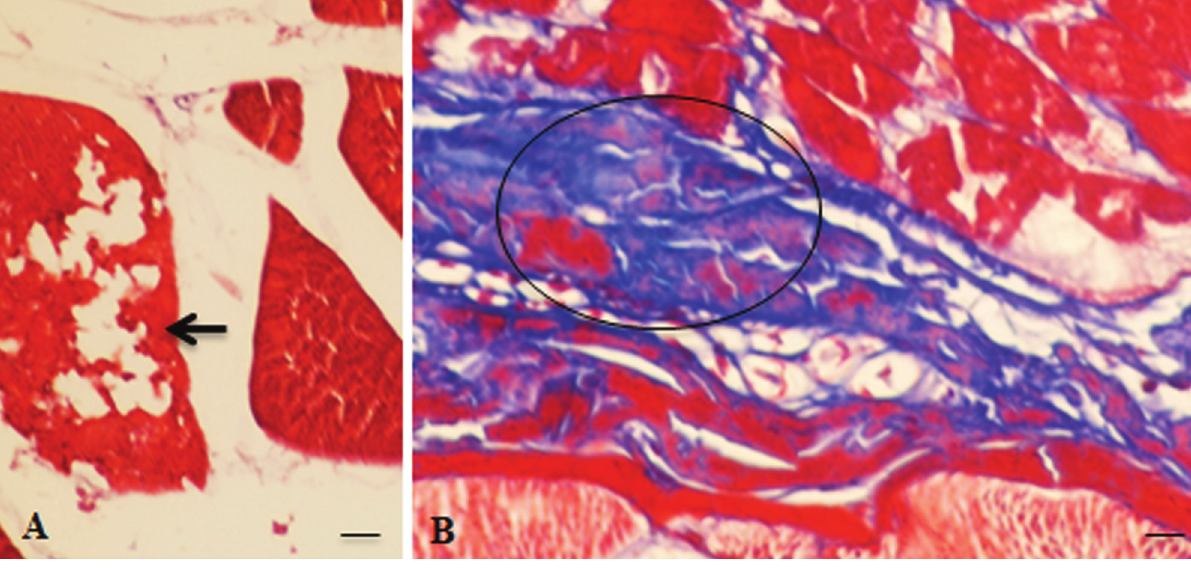
Fig. 3. A . Cellular apoptosis (black arrow). Transverse section. Masson trichrome. (Bar = 25 μm ) . B . Detail of the nerve (black circle). Transverse section. Masson trichrome. (Bar = 50 μm )